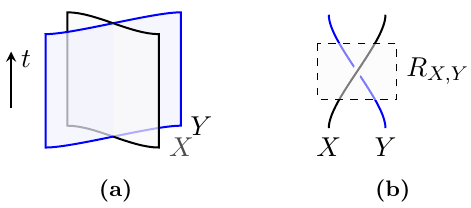
:= S 1 ∩ H z 0 ; (c): after a rotation in zt -plane, the braid B 1